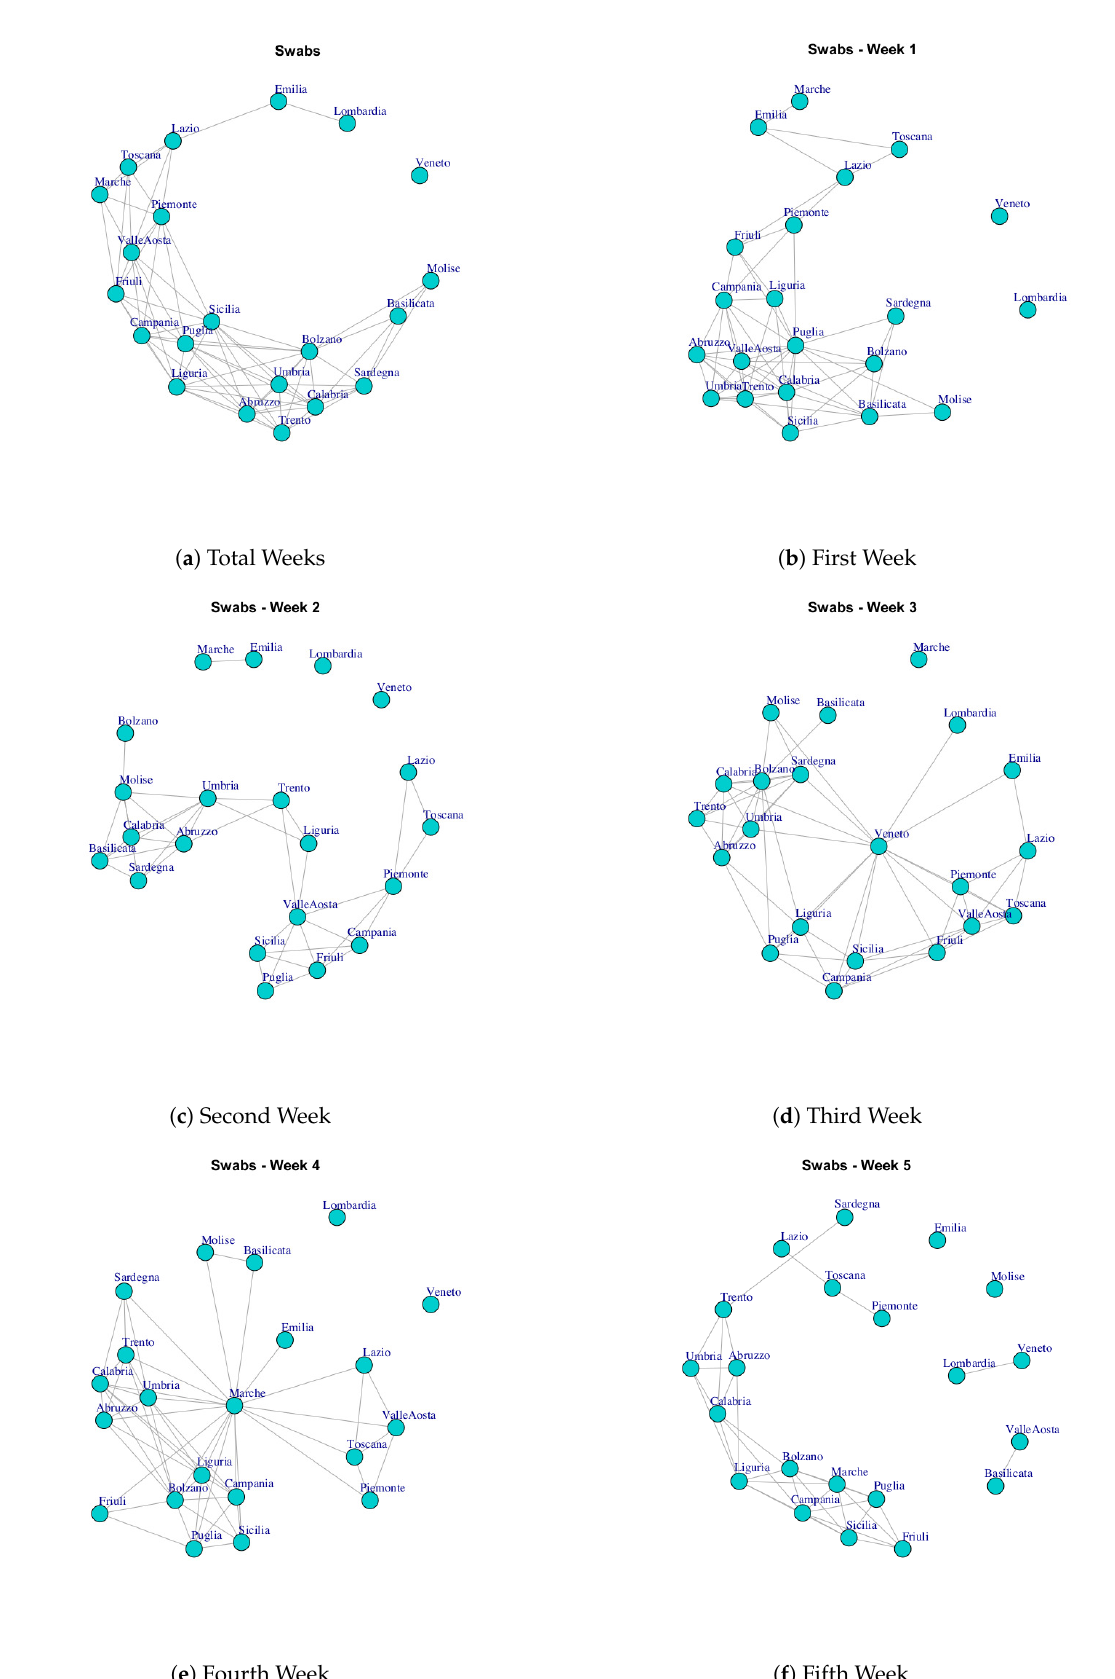
Figure 12. Evolution of Swabs